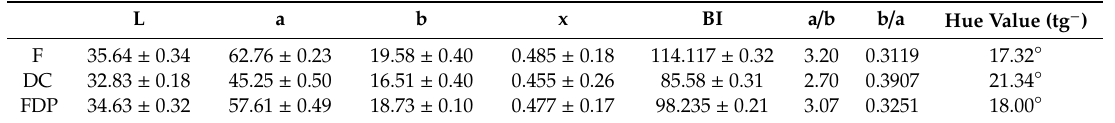
Table 3. The drying method e ff ect on the color of probiotic enriched beetroot